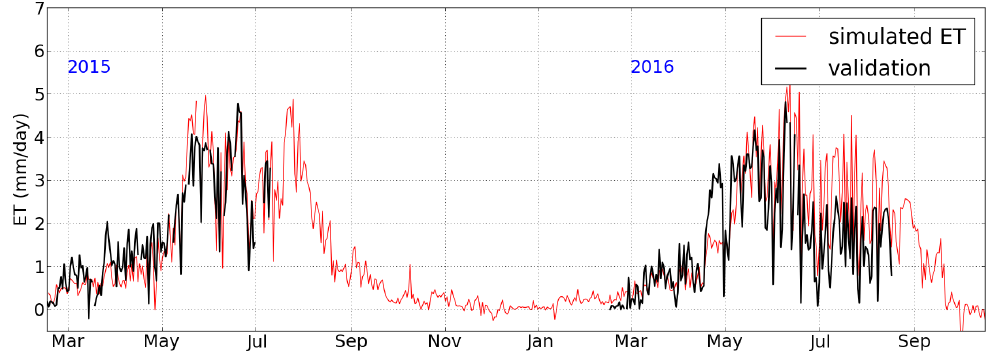
Figure 6. Daily ET as modelled at a 300 m spatial resolution and as obtained from in situ measurements at the flux tower in Rogozynek, Poland.